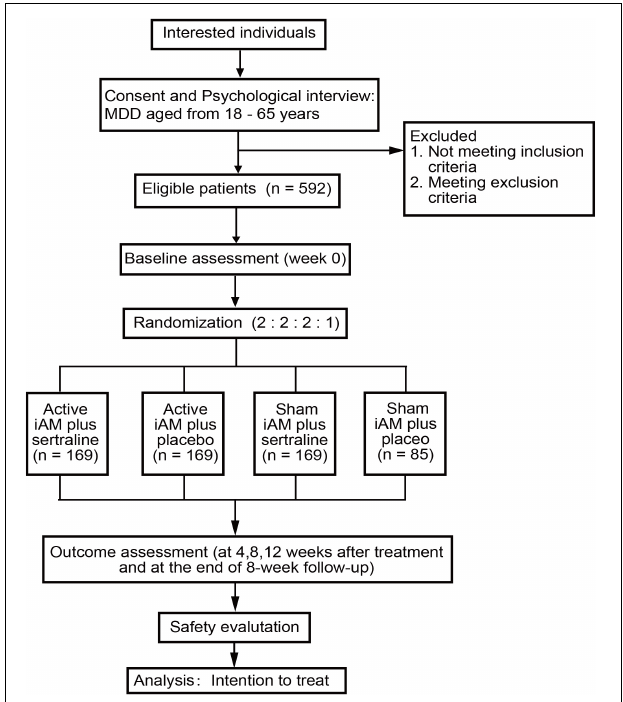
FIGURE 1 | Randomized trial flow